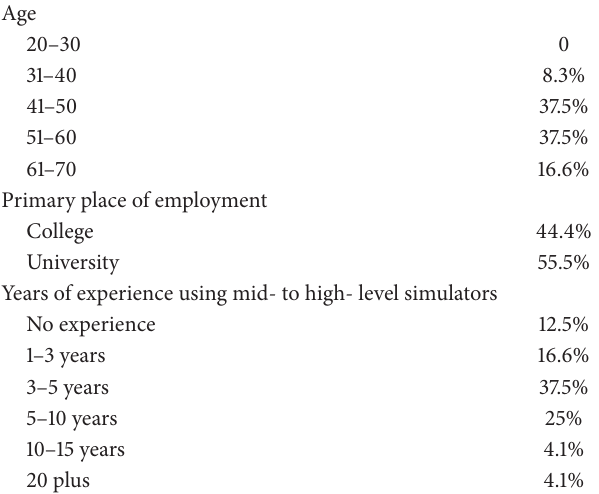
Table 1: Demographic